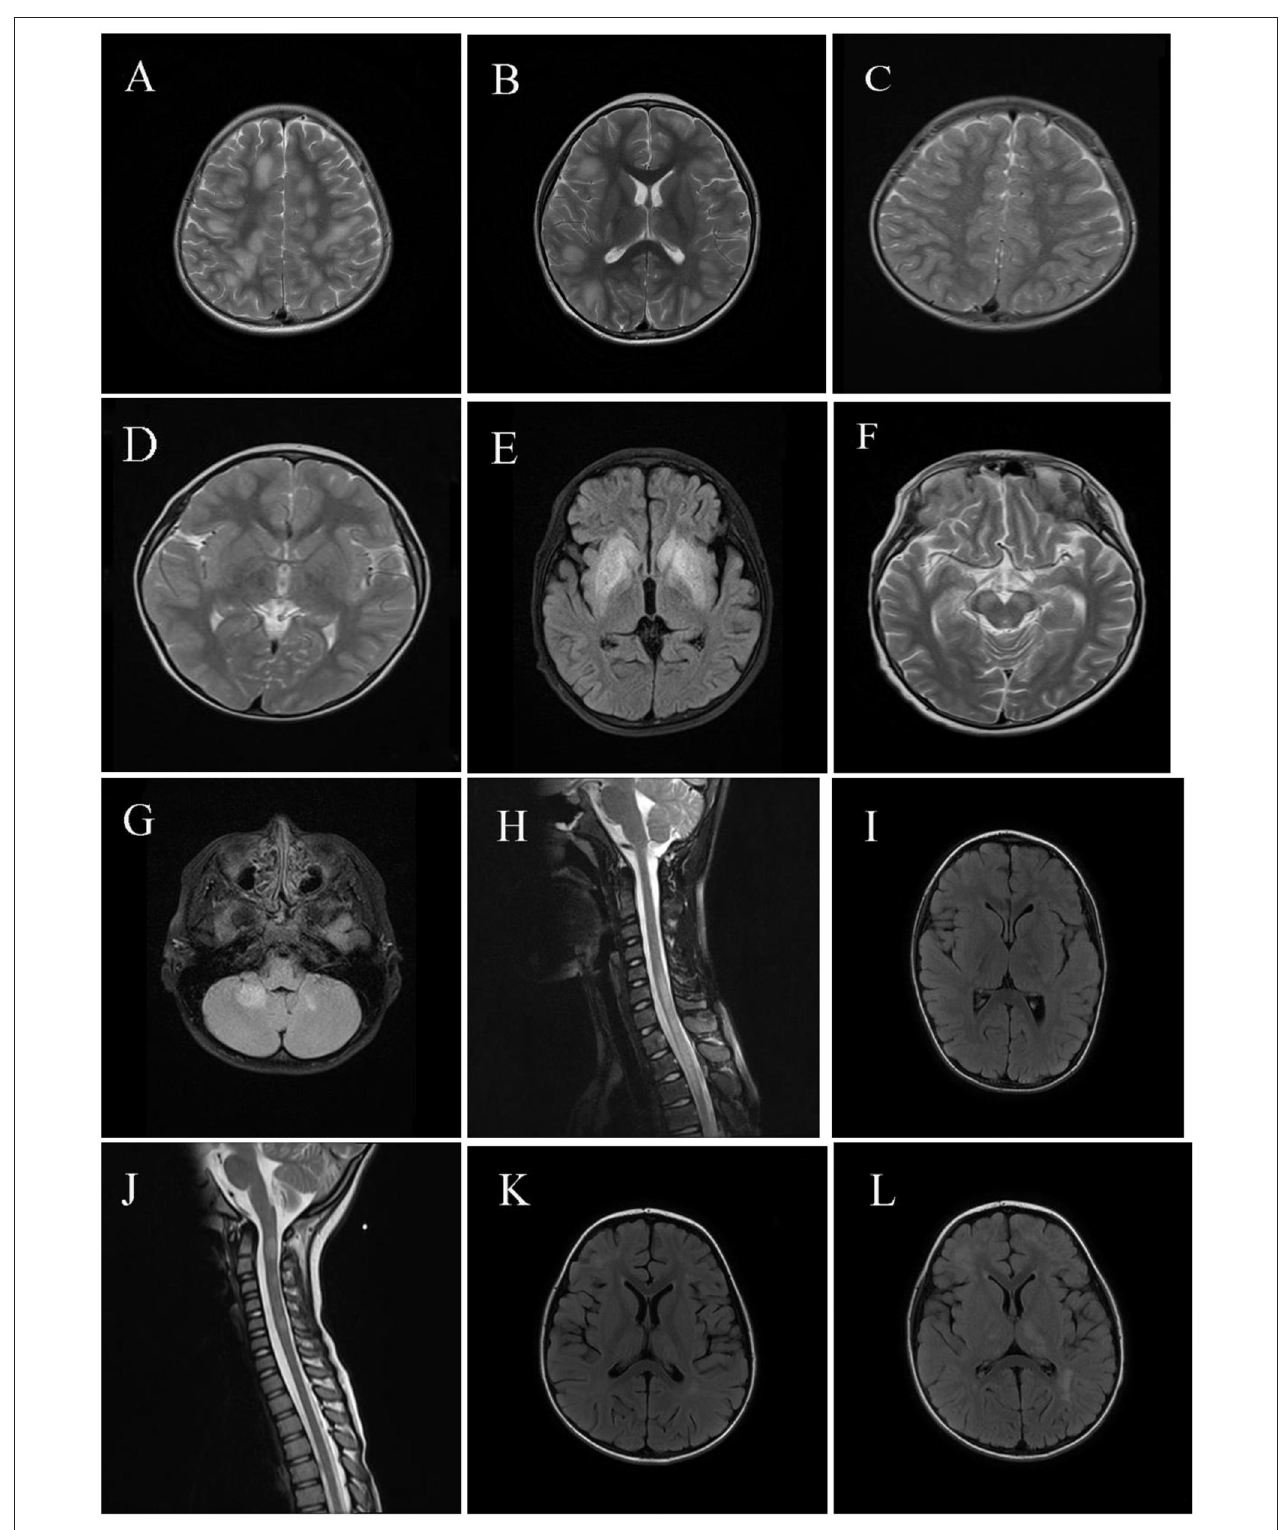
FIGURE 3 | Magnetic resonance imaging (MRI) results of pediatric acute disseminating encephalomyelitis (ADEM) without anti-myelin oligodendrocyte glycoprotein antibodies (MOG-abs). (A–D) Cerebral MRI of a 3-year-old patient with ADEM but without MOG-abs who presented with frequent seizures and coma, revealed widespread, blurred, and large lesions involving supratentorial of both hemispheres and basal ganglia lesions [ (A,B) ; axial-T2] similar to the typical cerebral MRI